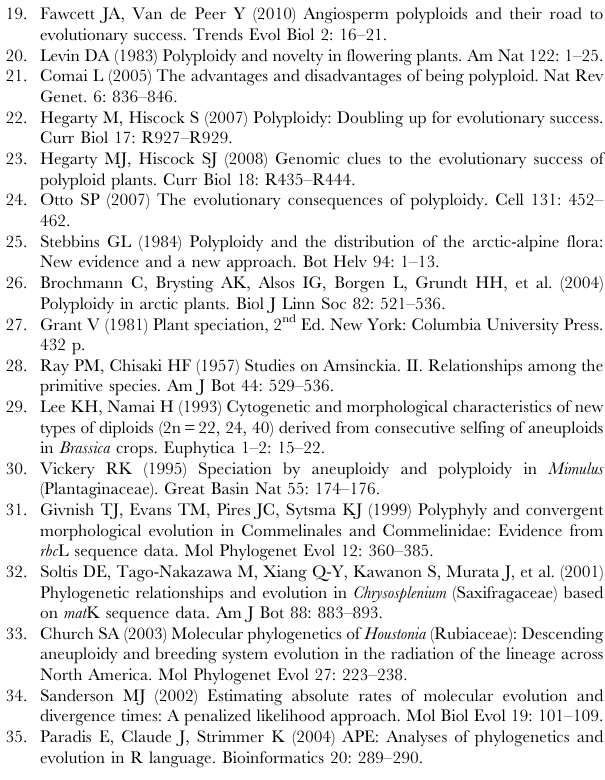
Figure S1. Linear model for the correlation between diploid chromosome number ( 2n ) and genome size (2C, pg) in Cistaceae. Figure S2. Linear model for the correlation between diploid chromosome number ( 2n ) and genome size (2C, pg) in Anti- rrhineae. Figure S3. Linear model for the correlation between diploid chromosome number ( 2n ) and genome size (2C, pg) in Saxifraga sect. Saxigraga . Figure S4. Linear model for the correlation between diploid chromosome number ( 2n ) and genome size (2C, pg) in Orchidinae . Figure S5. Linear model for the correlation between diploid chromosome number ( 2n ) and genome size (2C, pg) in Resedaceae. Figure S6. Linear model for the correlation between diploid chromosome number ( 2n ) and genome size (2C, pg) in Passiflora . (DOCX)